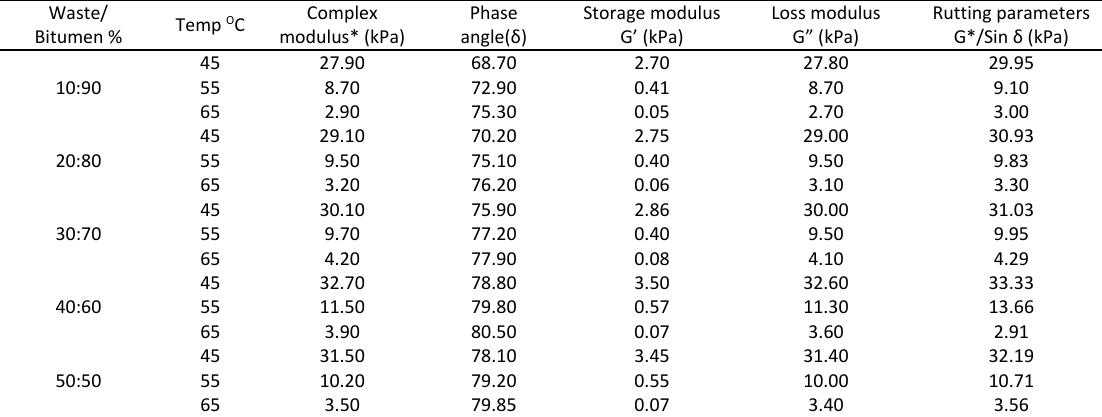
Table 3: Result of Rheological Properties of Shredded Tier Modified Bitumen (STMB) from Loda. Waste/ Bitumen